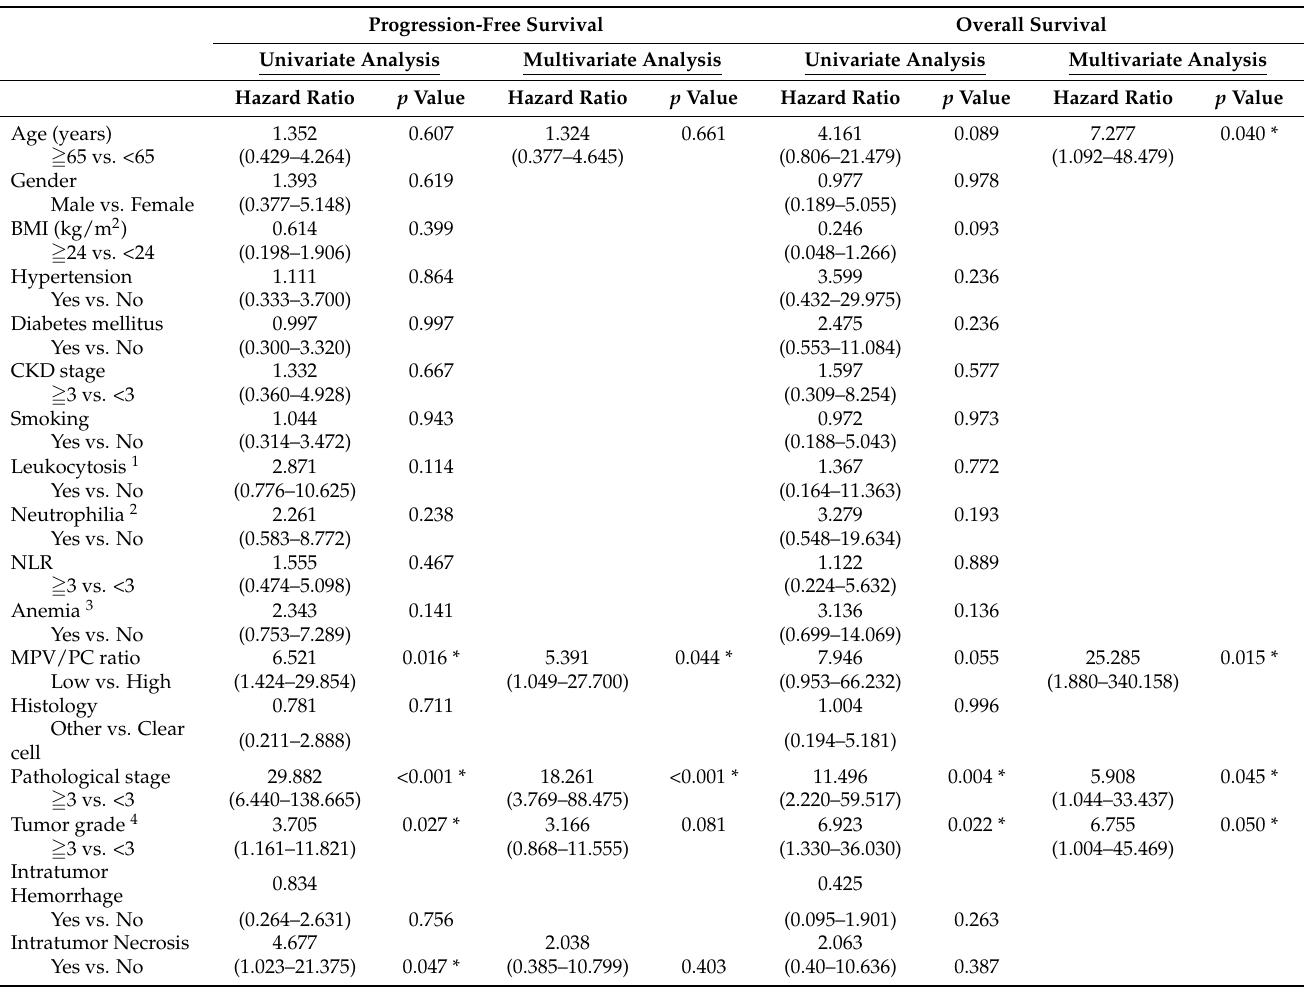
Table 2. Univariate and multivariate analyses of progression-free survival and overall survival in patients with renal cell